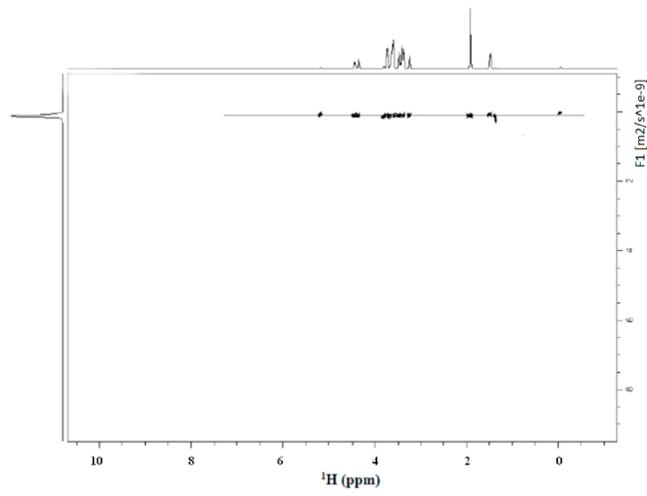
Figure 3. Diffusion ordered NMR (DOSY) experiment of the sample HA-PLA DAC ® in D 2 O-PBS after sterilization. The front of diffusion indicated a Diffusion coefficient D = 8.91 × 10 − 11 m 2 s − 1 . A weak resonance is reported at 0 ppm probably due to the silyl moiety of DSS bound to the macromolecule.